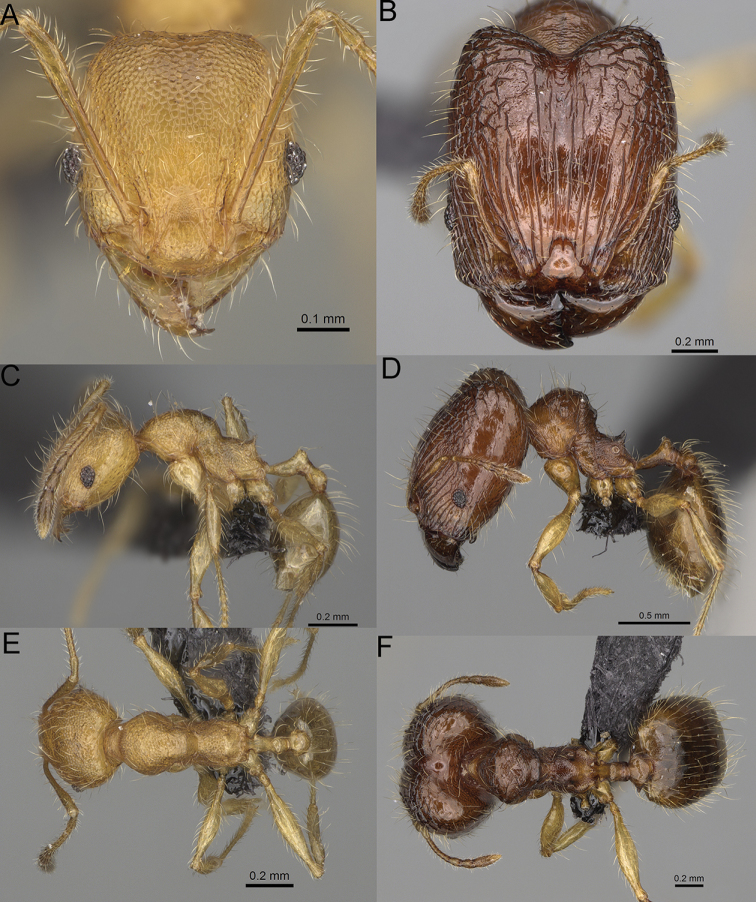
Pheidole
makaensis sp. nov., full-face view (A), profile (C), and dorsal view (E) of paratype minor worker (CASENT0923188) and full-face view (B), profile (D), and dorsal view (F) of holotype major worker (CASENT0205745).